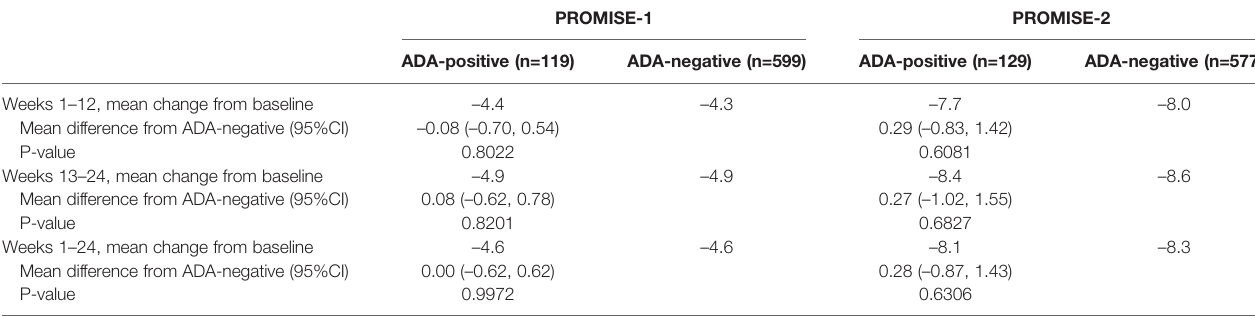
TABLE 6 | Change in monthly migraine days by ADA status in PROMISE-1 and PROMISE-2 (full analysis population; all dose levels combined)*.